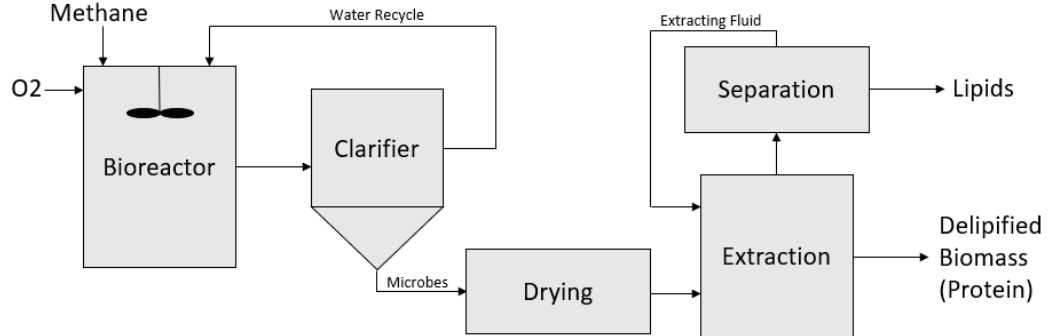
Figure 1. General Processing Method of Producing Lipids and Protein from Methanotrophs.